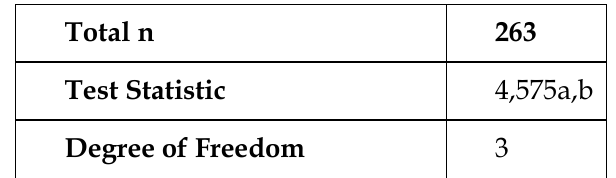
Table 32. Willingness to use the Digital Health Centre and education. Kruskal-Wallis sig. test. The test statistic is adjusted for